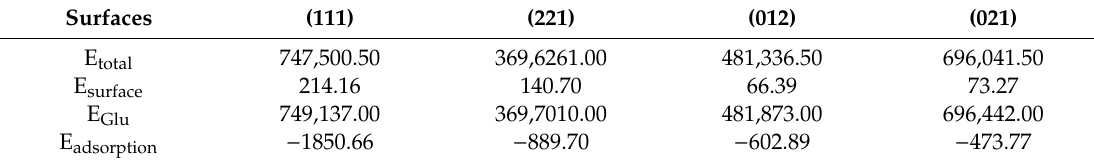
Table 2. The interaction energy between Glu and various aragonite crystal planes (kcal / mol).